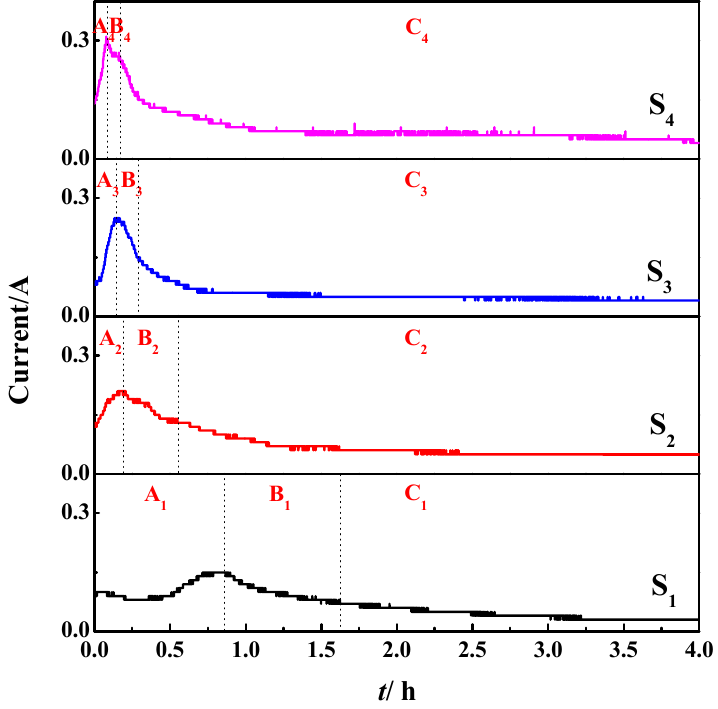
Figure 4. The current–time curves during electrolysis of S 1 (mFe 2 O 3 /mAl 2 O 3 = 1:1), S 2 (mFe 2 O 3 /mAl 2 O 3 = 3:2), S 3 (mFe 2 O 3 /mAl 2 O 3 = 2:1), and S 4 (mFe 2 O 3 /mAl 2 O 3 = 4:1) at 2.3 V, 850 °C, and 4 h.